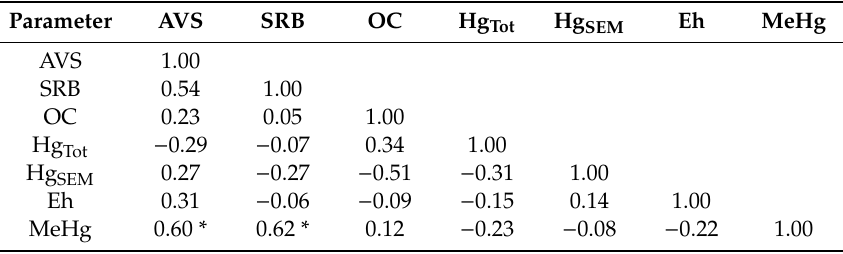
Table 5. Correlation coe ffi cients between investigated